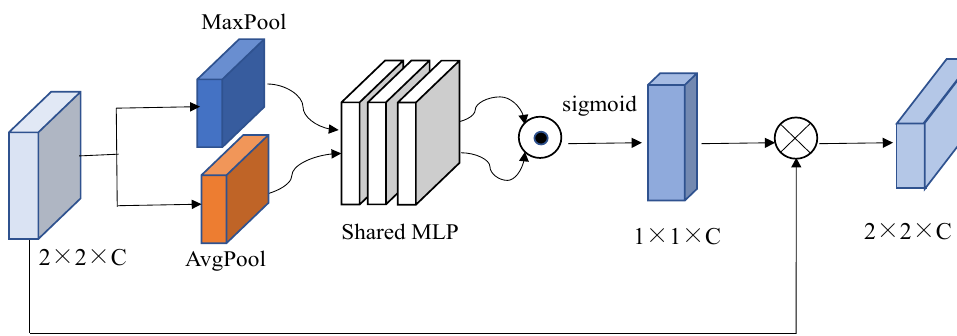
Figure 3. Spectral Attention